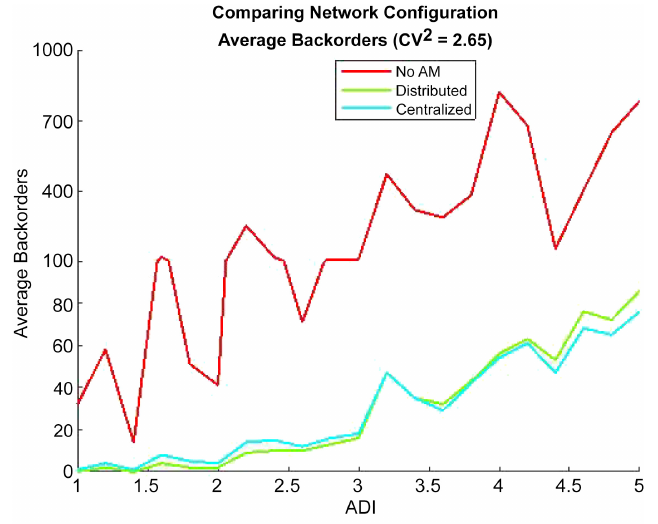
Figure 12. (Color online) Performance comparison of network configurations with CV 2 5 2.65 for all ADI